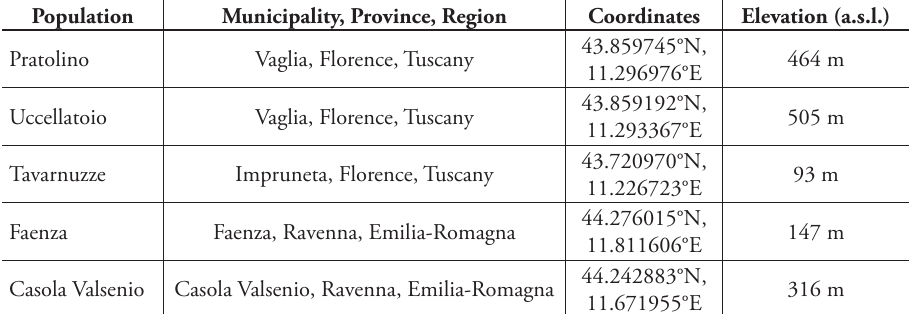
Table 1. Studied populations of Bellevalia webbiana